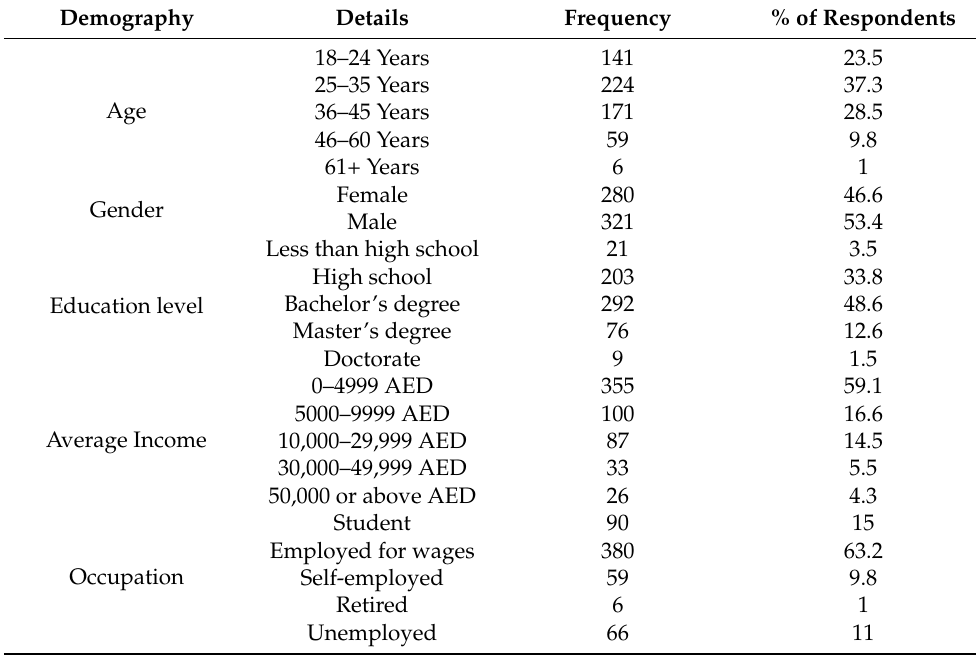
Table 2. Demographic analyses of